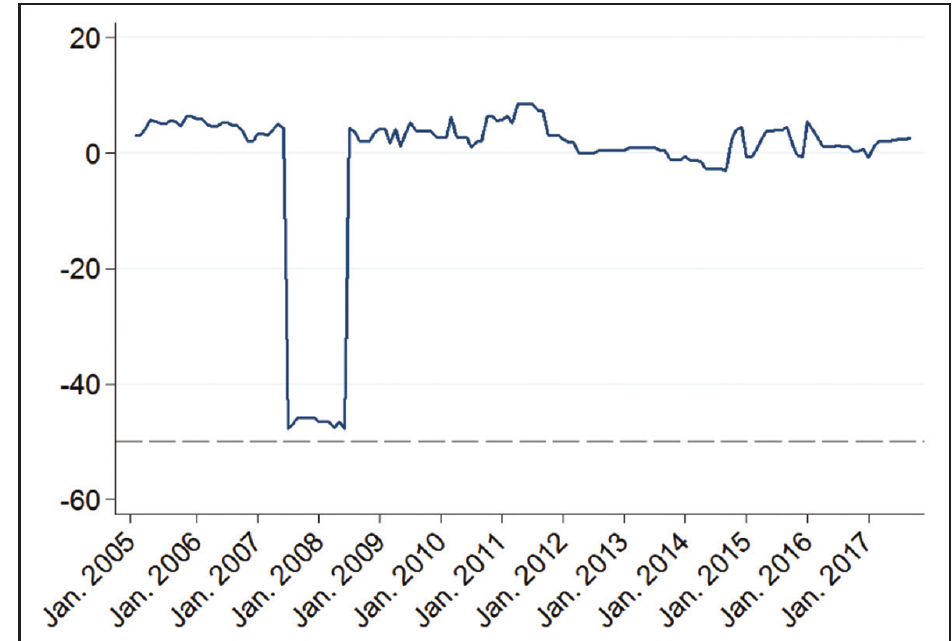
Percentage change in the hourly price of domestic cleaning services compared to the same month in the previous calendar